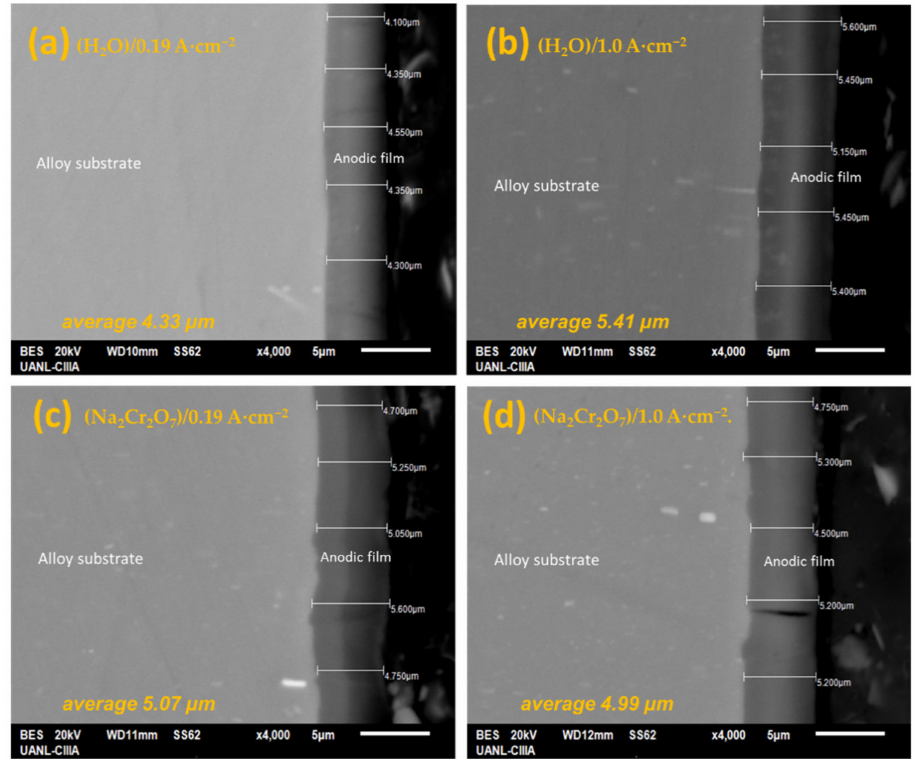
Figure 2. SEM-BES cross-sectional micrographs of the anodized AA2055 samples with different sealing treatments: ( a ) S1, ( b ) S2, ( c ) S3, and ( d )